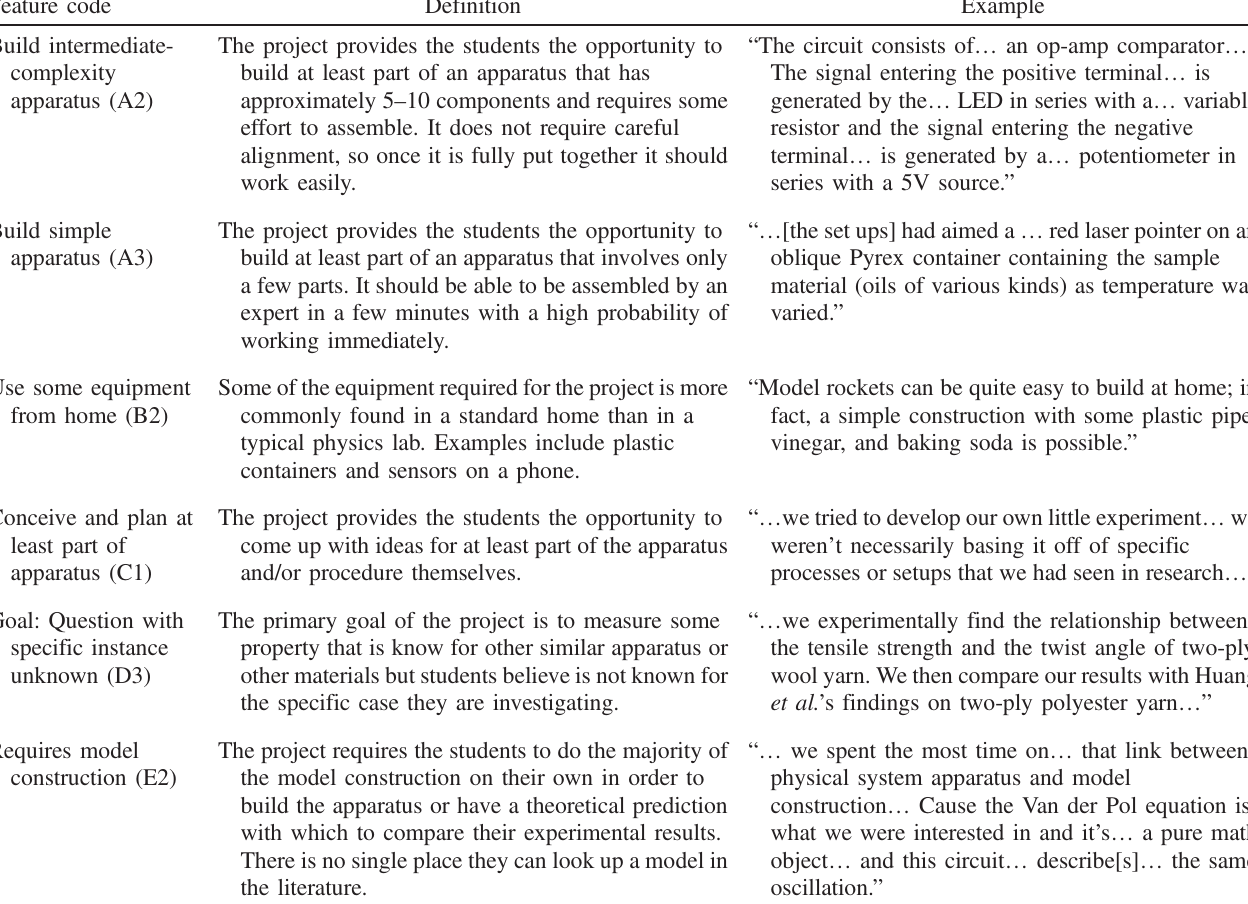
TABLE IV. Project feature codes most strongly associated with model construction along with their shortened definitions and example quotes from the student data sources (full definitions are in Table V in Appendix